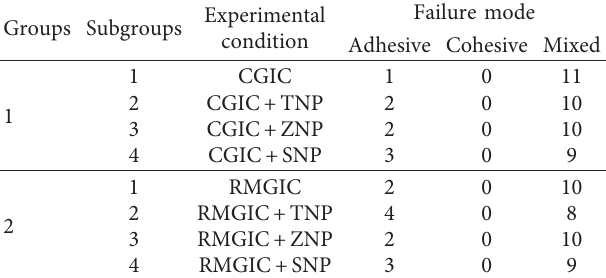
Table 3: Results of failure mode